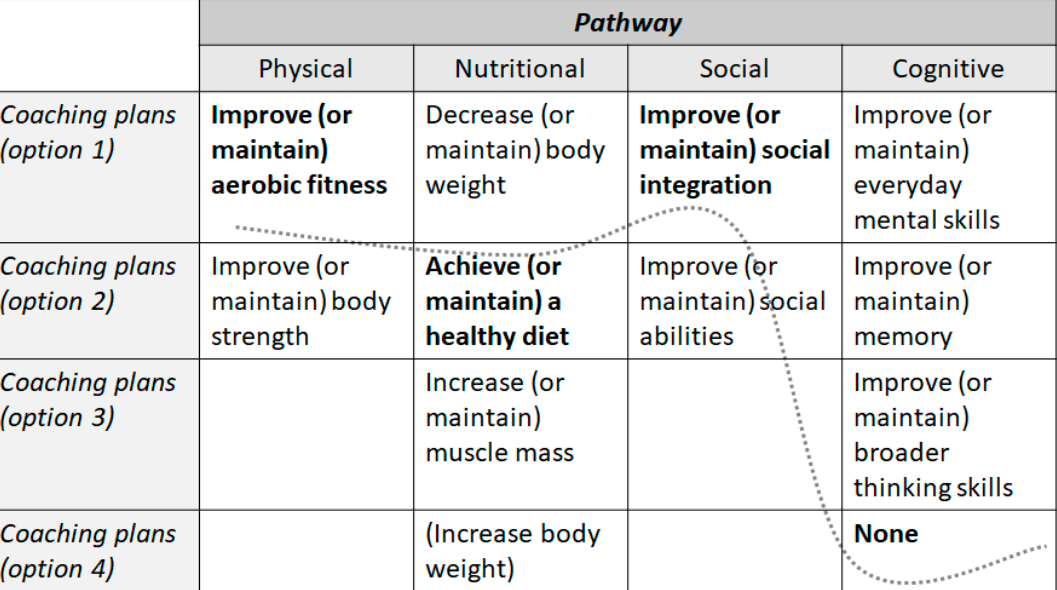
Figure 4. Summary of the possible pathways for a NESTORE user. In parenthesis are noted the alternatives for each coaching plan, which will be personalized according to the user needs in the specific sub-domain. For example, a user with good level of aerobic fitness and poor level of body strength will be able to choose between “Maintaining aerobic fitness” and “improving body strength”. The user is asked to choose one coaching plan in each domain, training at the same time all the dimensions of well-being. Only the cognitive domain can be skipped if there is no need for improvement. In bold, highlighted with the dashed line, a possible pathway